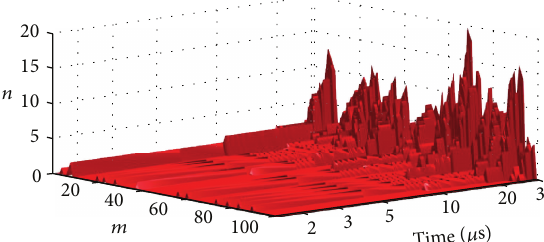
Figure 5: Time evolution of 2D distribution of defects calculated with the proposed model in the specific case of 𝑉 𝑃 = 6